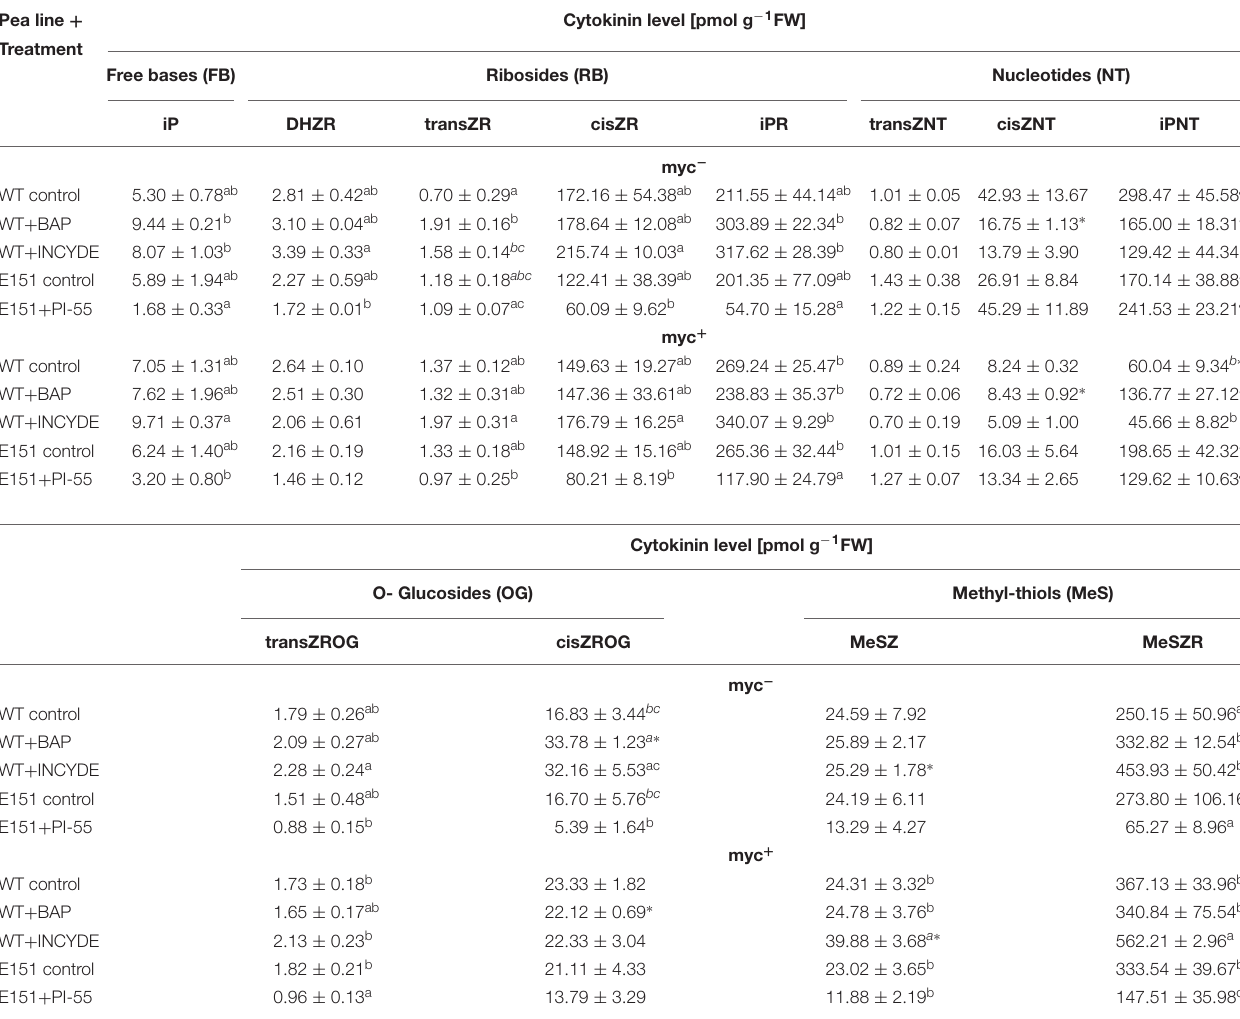
TABLE 2 | Levels [pmol g − 1 of FW] of CK isolated from shoots of non-mycorrhizal (myc − ) and mycorrhizal (myc + ) pea plants. Pea line